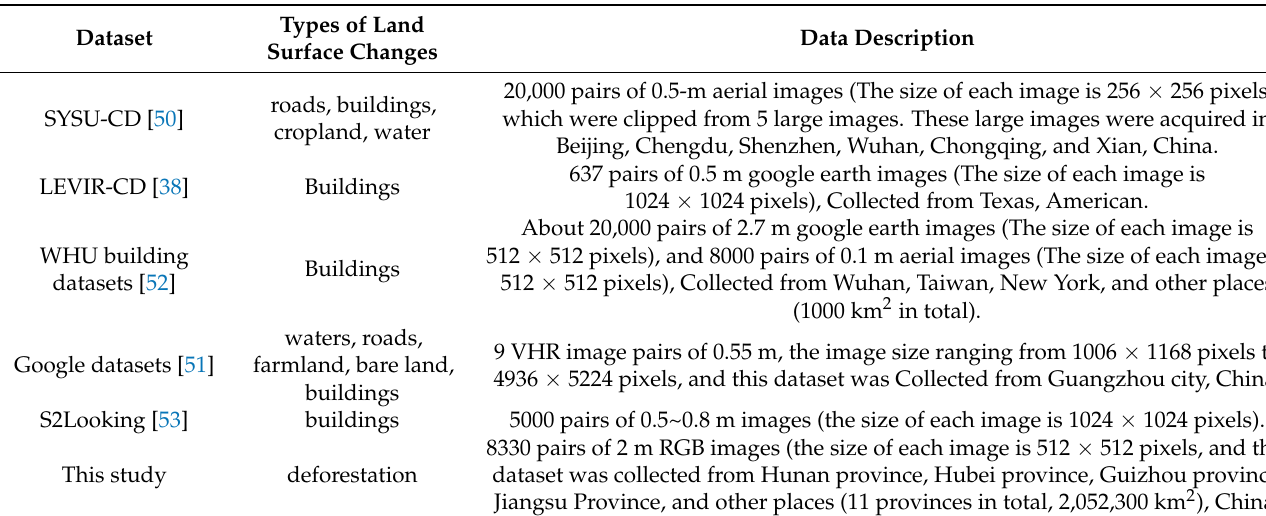
Table 4. Change detection datasets